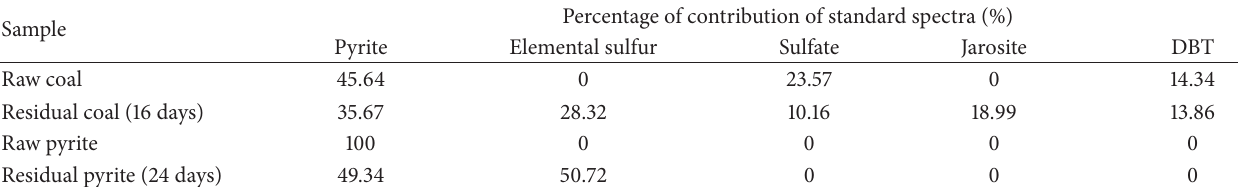
Table 2: The fitting results of S K-edge XANES spectra of measure sample with different reference